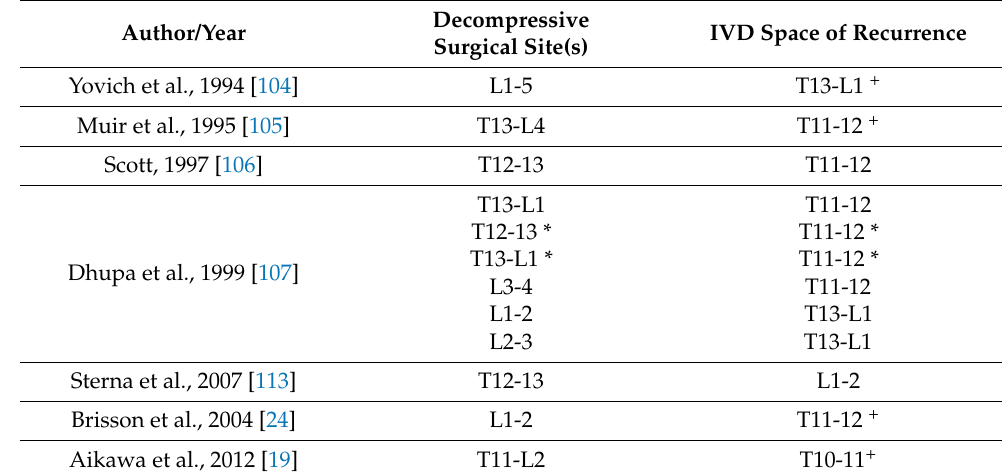
Table 4. Recurrence of intervertebral disc herniation cranially to the primary surgically treated